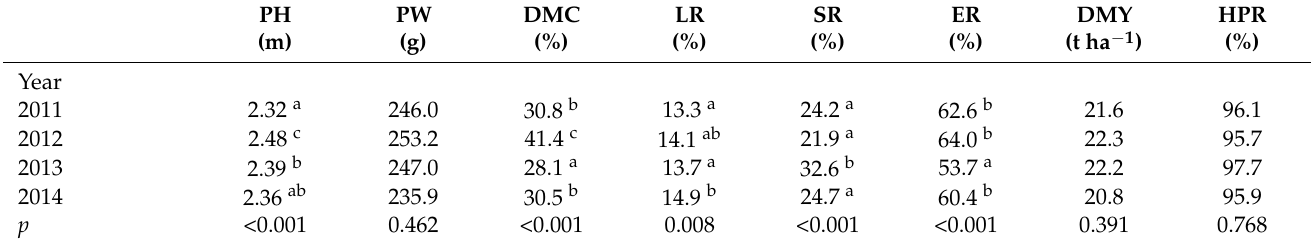
Table 4. Plant height (PH), plant weight (PW), dry matter content (DMC), leaf ratio (LR), stalk ratio (SR), ear ratio (ER), dry matter yield (DMY) and harvested plant ratio (HPR) for two row spacings (RS, 0.70 m and 0.35 m) at a plant density of 92,000 plants ha − 1 at harvest time in 2011–2014